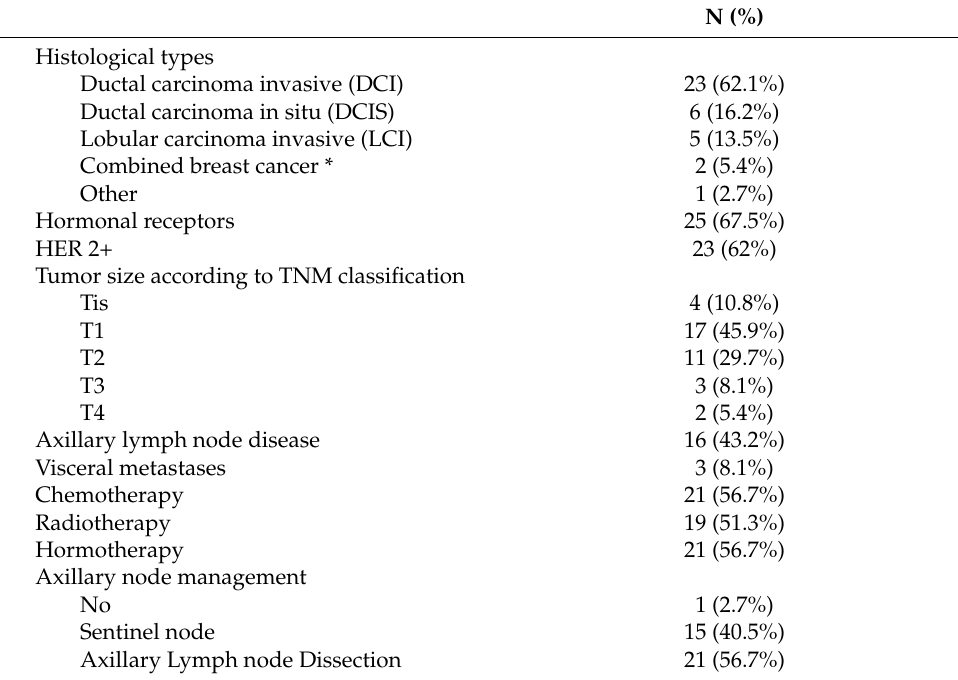
Table 2. Oncological characteristics ( n =